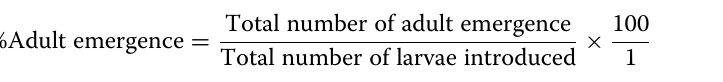
Inhibition rate (IR) of adult emergence was